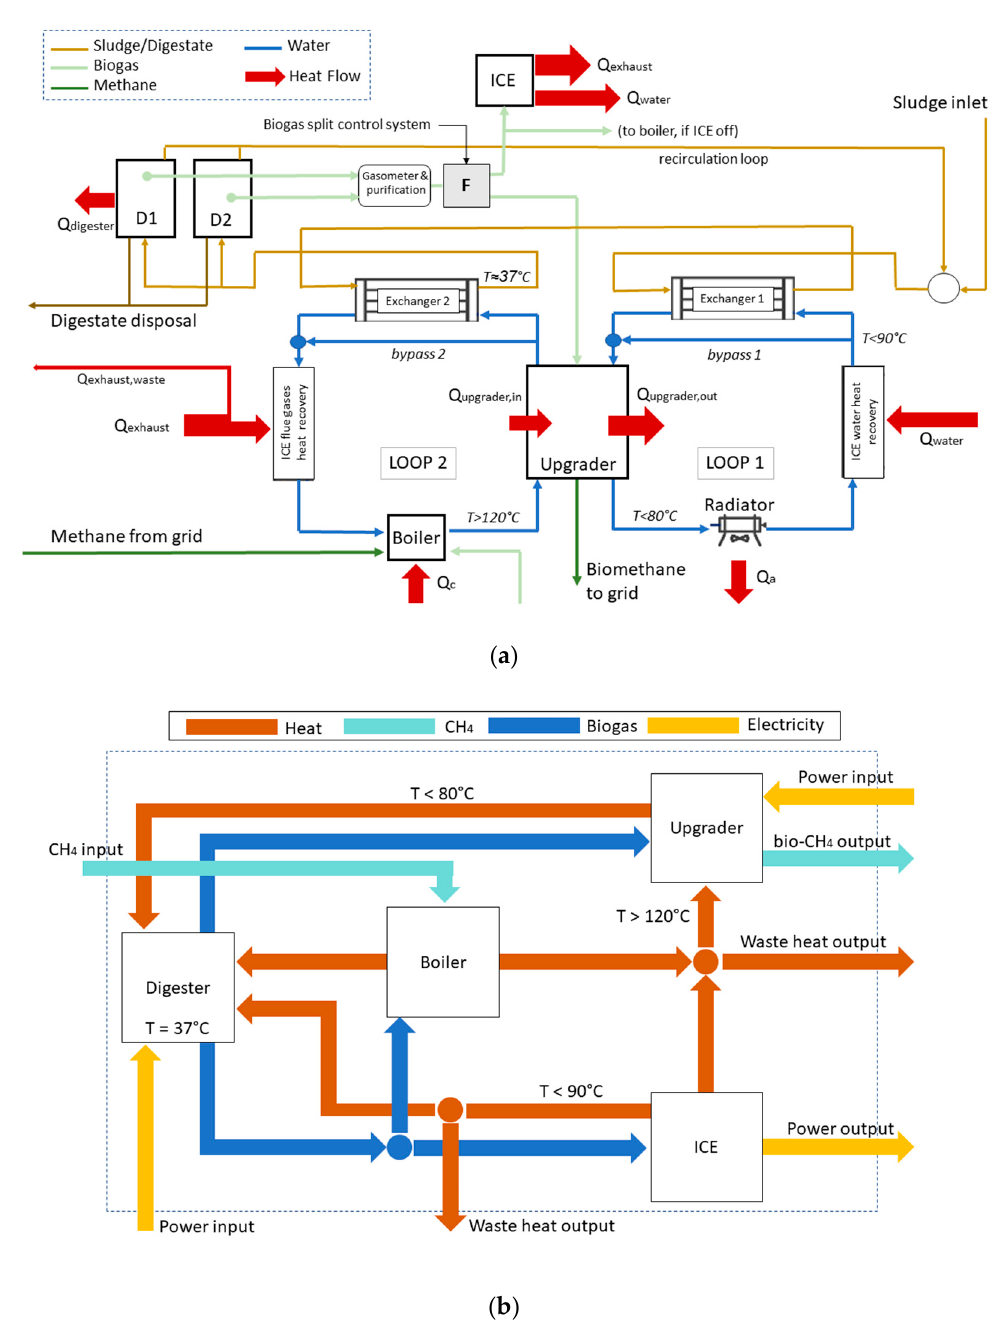
Figure 1. Plant scheme ( a ) and the mass and energy fluxes involved ( b